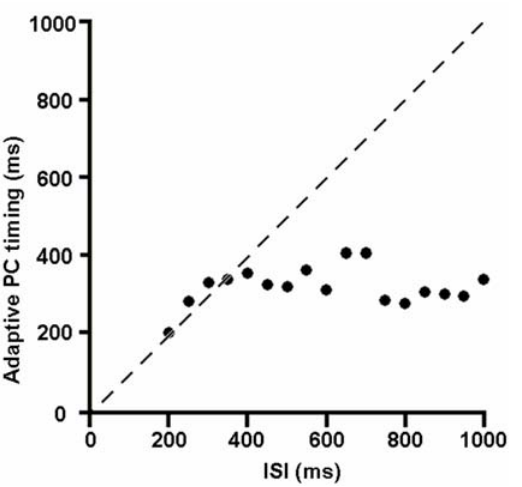
Figure 11. Noise disrupts performance of adaptive-PC timing model. When a more natural activation pattern of noisy CFs was used, its performance dropped at increasing ISIs. This model is vulnerable to intervening noise pulses because it is not based on a large population of neurons. The dashed line indicates the ideal relationship for the data points. See text for details.